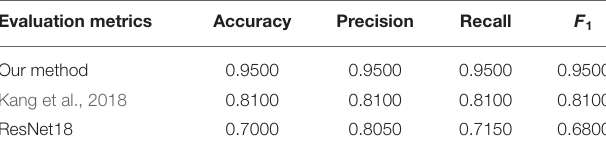
TABLE 4 | Experimental results of our method and the compared